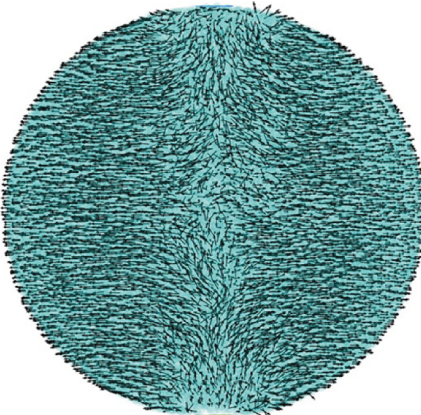
Figure 10: Velocity field of particle